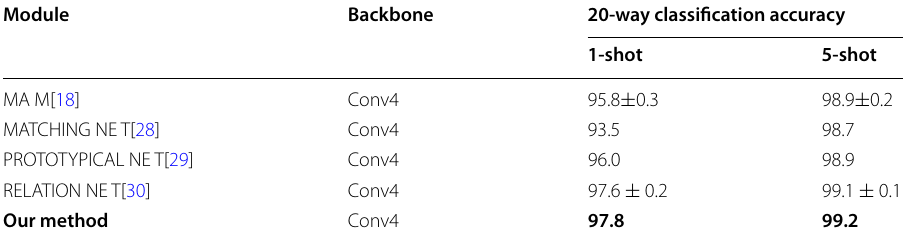
Table 4 Classification accuracy of few-shot image on omniglot dataset (%) Module